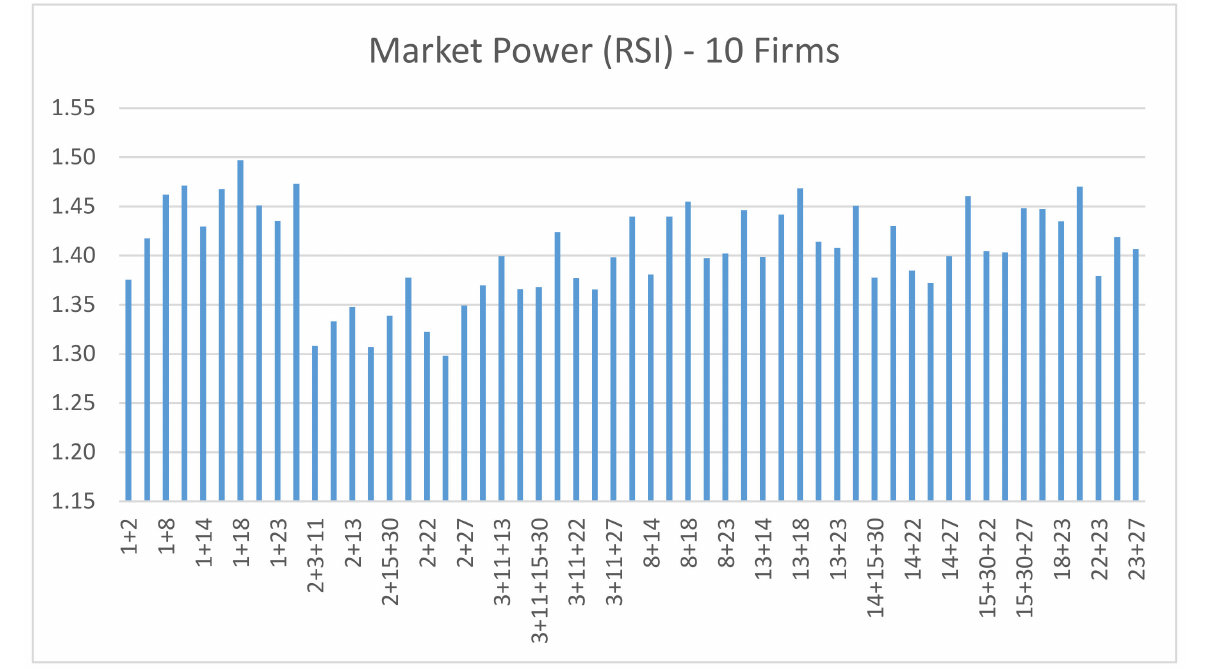
Figure 7. RSI for 10 firms’ setting (PC).